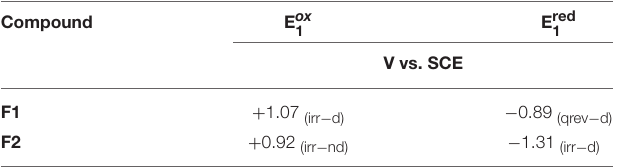
TABLE 1 | Electrochemical signals description for F1 and F2